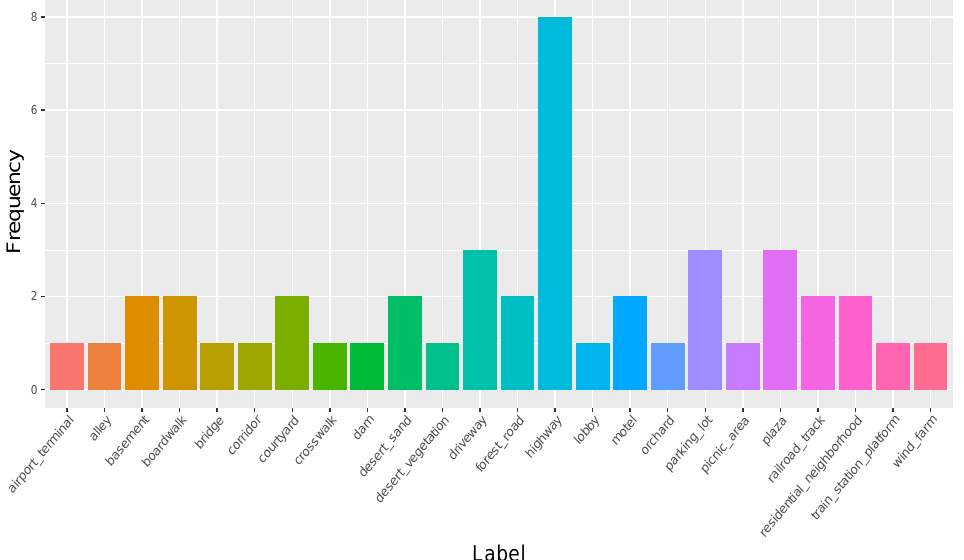
Figure 16. Label histogram produced with the Average-BrayCurtis-0.6 combination, smoothed with K = 15.